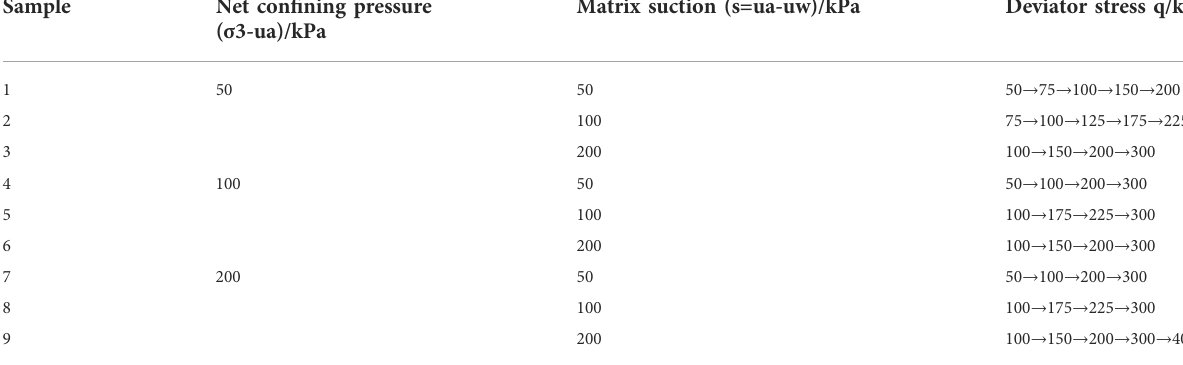
TABLE 2 Triaxial creep test scheme for unsaturated silty clay.